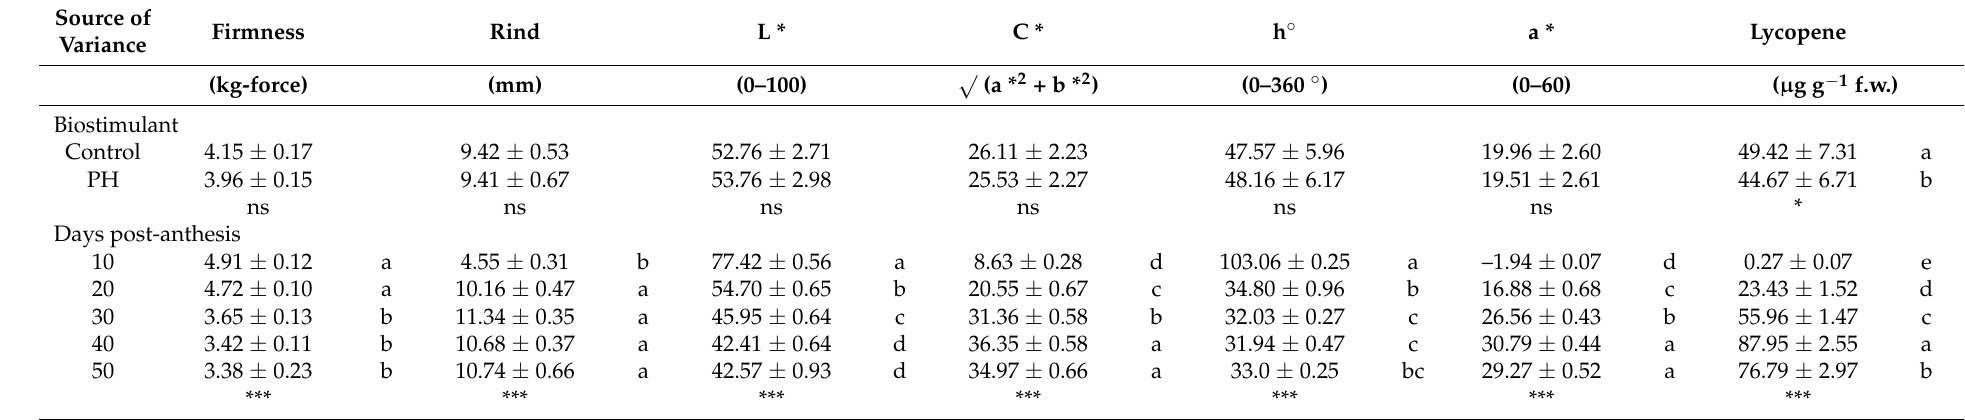
Table 2. Mean comparisons for pulp firmness, fruit rind, flesh CIELAB color components, and lycopene content of watermelon cv. Obla harvested at 10, 20, 30, 40, and 50 days post-anthesis with (PH) or without (Control) protein hydrolysate biostimulant